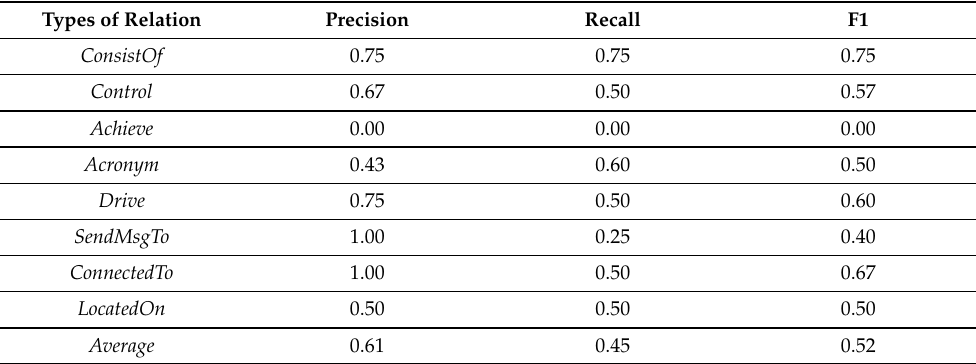
Table 9. Relation extraction based on recognized